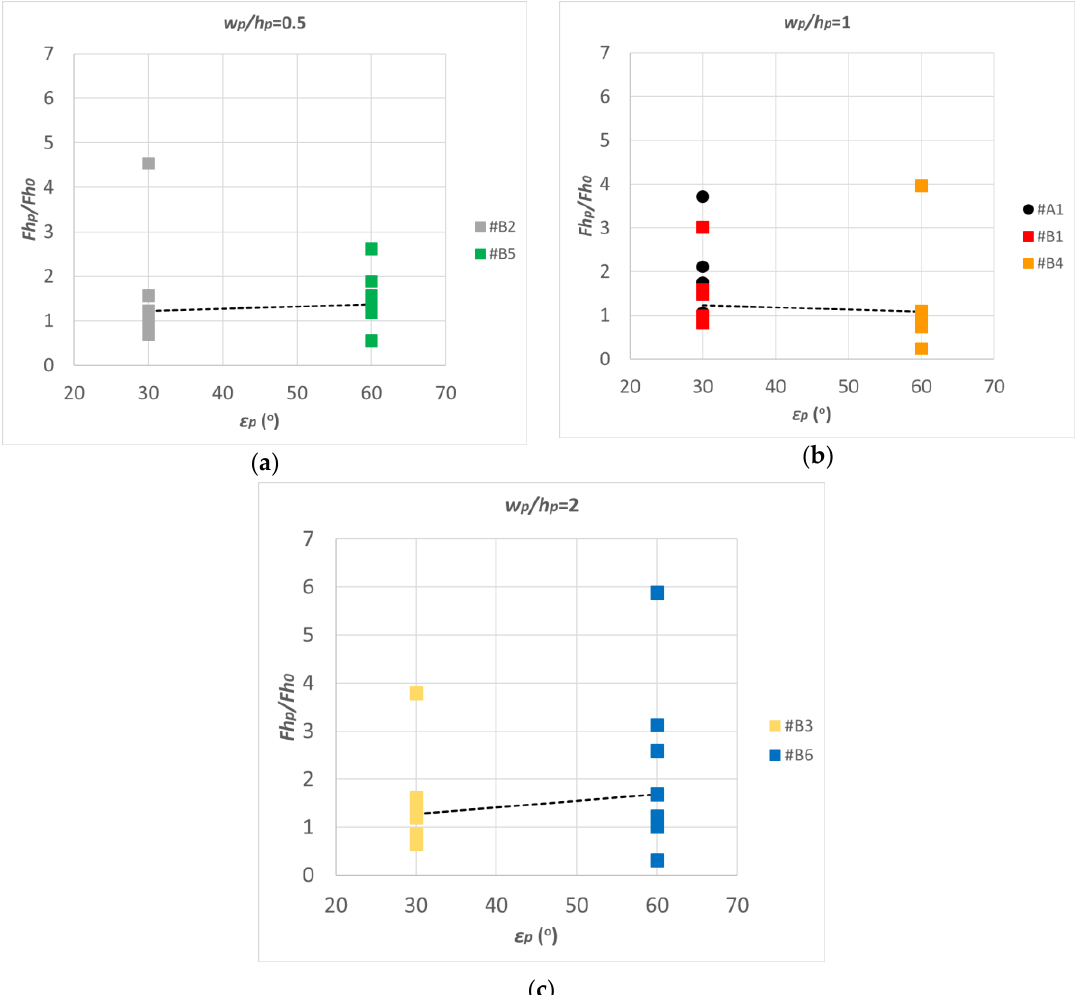
Figure 13. Influence of the parapet angle on Fh p /Fh 0 for ( a ) w p /h p = 0.5, ( b ) w p /h p = 1, and ( c ) w p /h p =